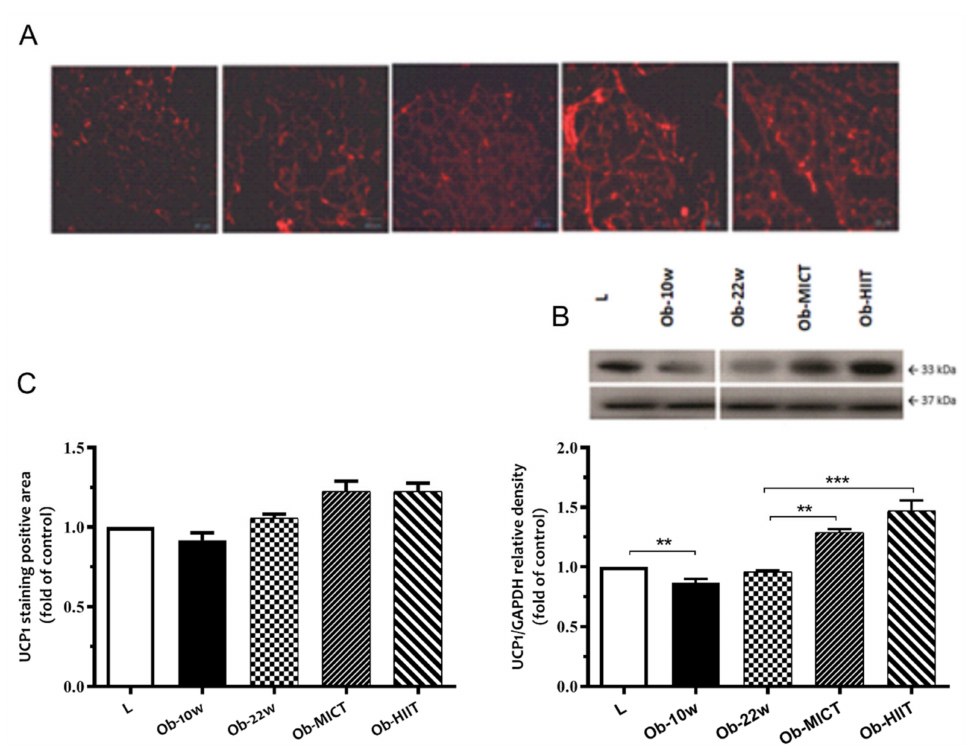
Figure5. The e ff ect of obesity and exercise training on uncoupling protein (UCP)1. ( A ) Immunofluorescence images of UCP1 positive cells in subcutaneous adipose tissue, ( B ) Western blot analysis for UCP1 and GAPDH, and ( C ) mean UCP1 abundance as determined by immunohistochemistry and Western blotting. Data are represented as means ± SEM ( n = 6) and significant di ff erence between groups indicated by ** p < 0.01, *** p < 0.001. L: lean; Ob-10w: obesity-10 weeks; Ob-22w: obesity + sedentary; Ob-MICT: obesity + moderate-intensity continuous training; Ob-HIIT: obesity + high-intensity interval training (HIIT).